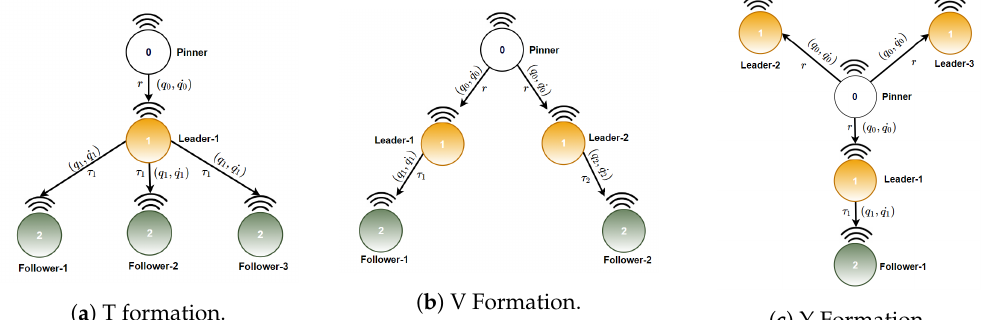
Figure 14. Communication graphs for inverted T, inverted V and Y